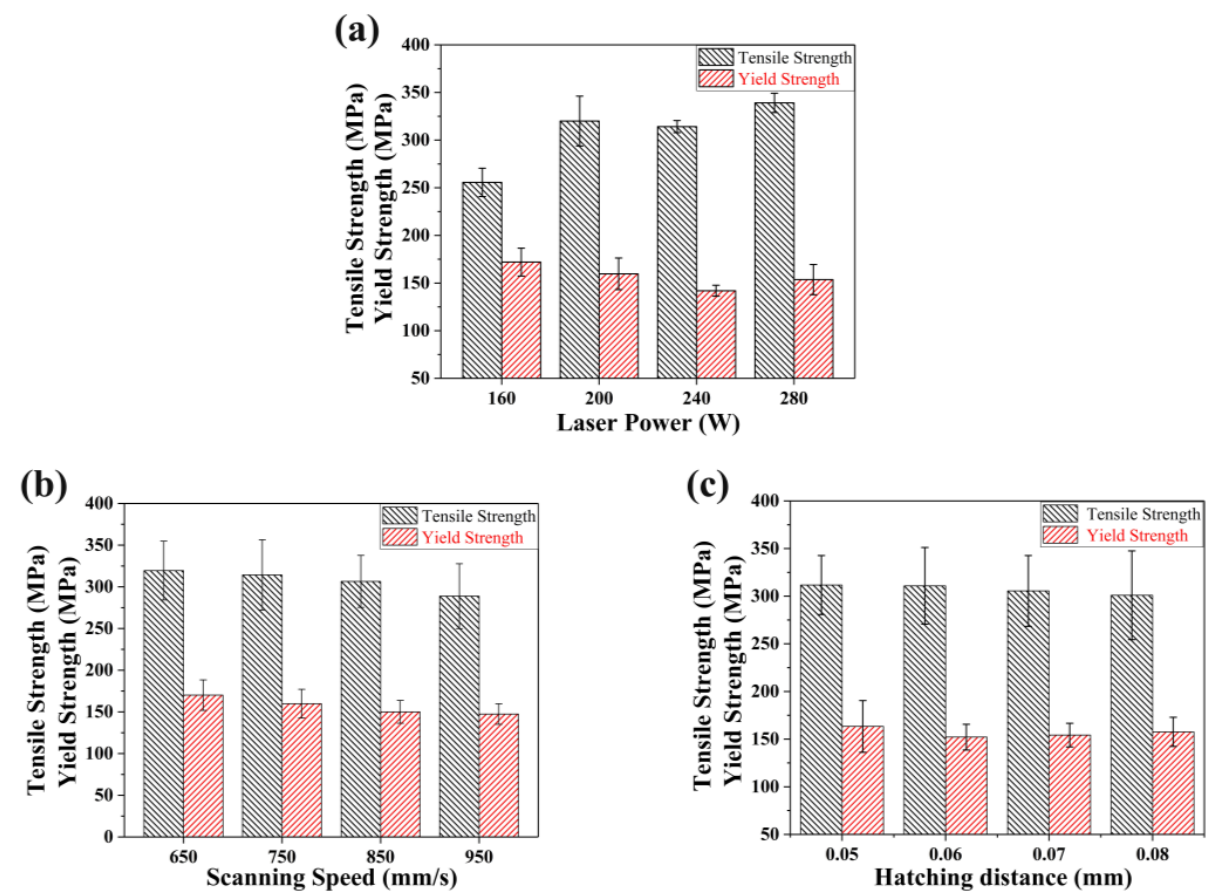
Figure 8. The influence of process parameters on the tensile properties of samples: ( a ) Laser Power, ( b ) Scanning Speed, ( c ) Hatching Distance.